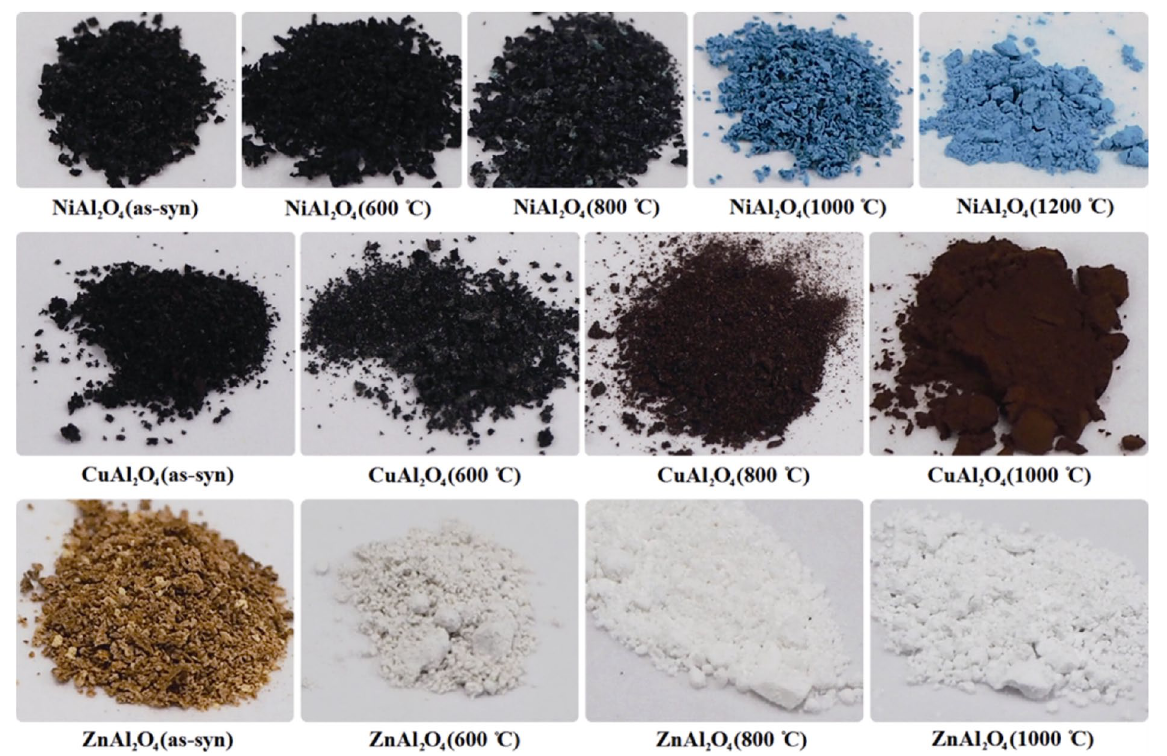
Fig. 6 Photographs of NiAl 2 O 4 , CuAl 2 O 4 , and ZnAl 2 O 4 powders calcined at different